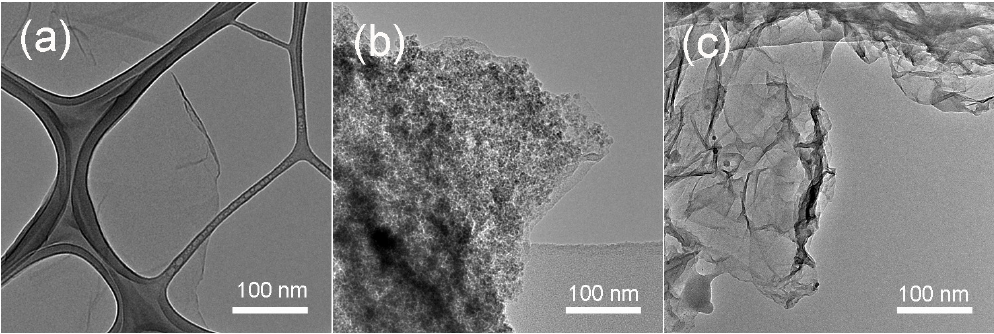
Figure 4. TEM (transmission electron microscopy) images of the ( a ) GO, ( b ) r-GO/Fe 2 O 3 , and ( c ) r-GO sheets.